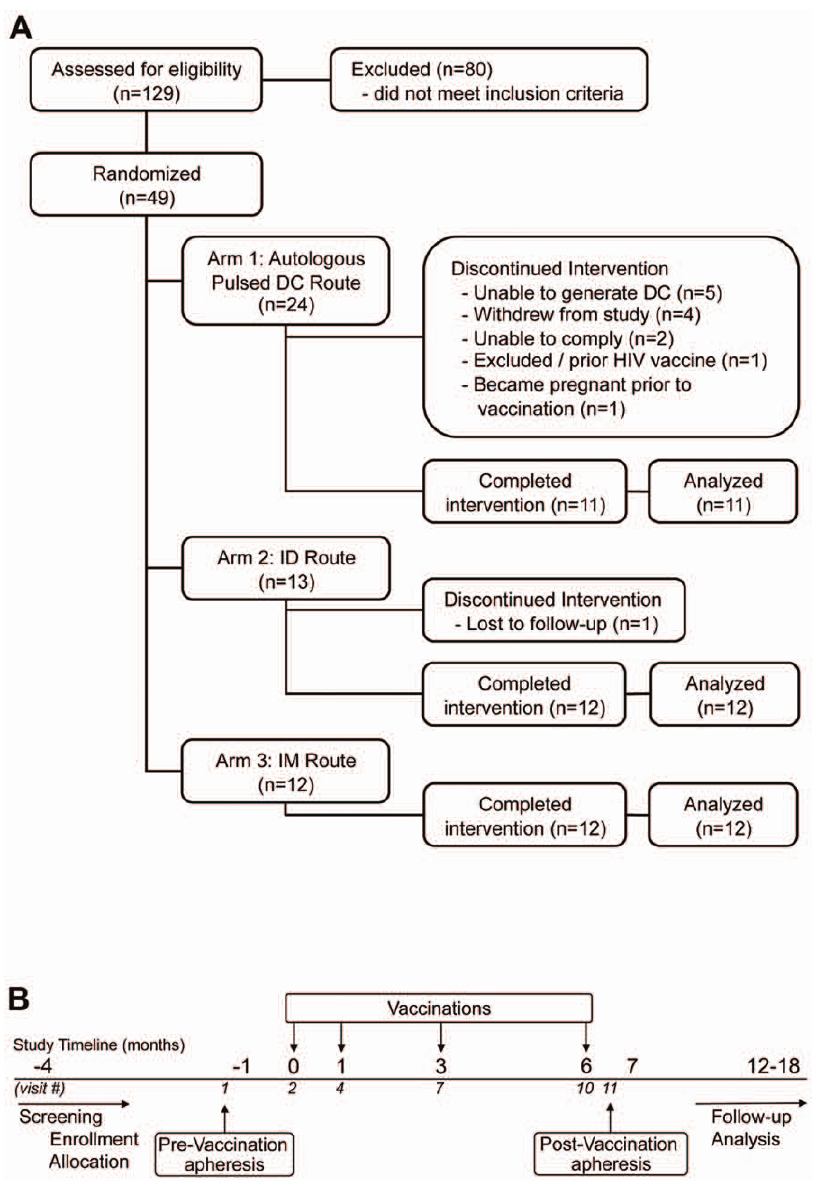
Figure 1. Study Design. (A) Consort diagram. (B) Study timeline. Vaccinations were administered at 0, 1, 3 and 6 months. All study subjects underwent apheresis prior to initial vaccination (visit 1) and 2 weeks following the final vaccination (visit 11).